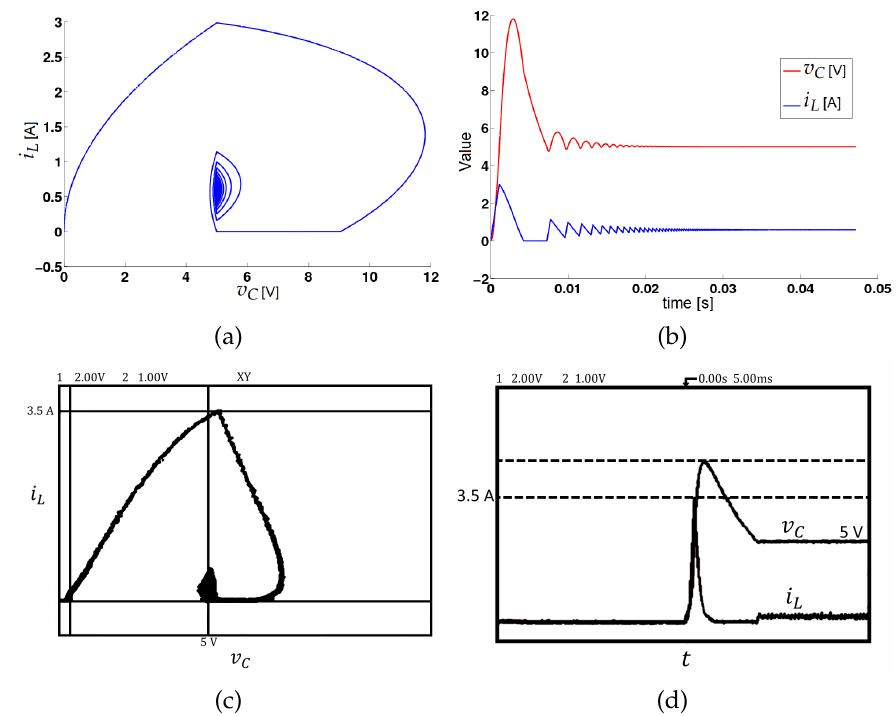
Figure 21. Numerical simulation vs. experimental results in the steady- and transient-state operations with ξ = 0 V and v c = 5 V: ( a ) experimental phase diagram, ( b ) experimental temporal evolution, ( c ) theoretical phase diagram, and ( d ) theoretical temporal